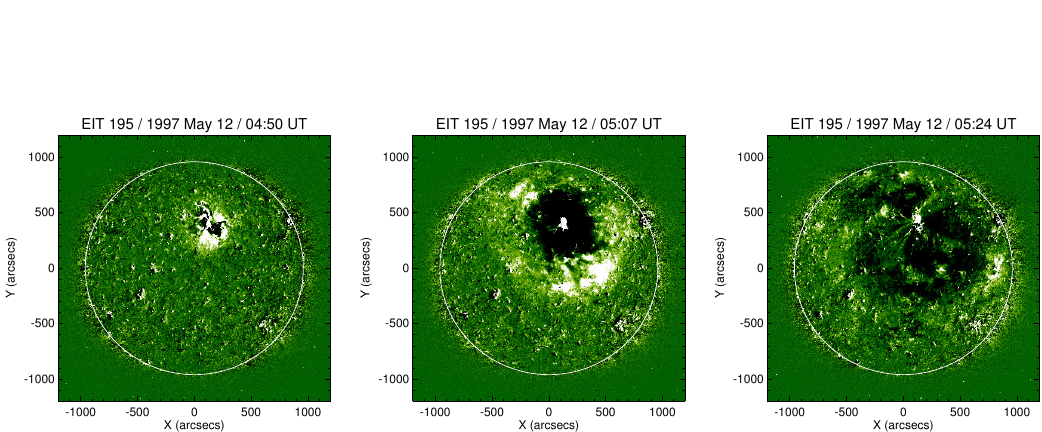
Figure 3: One of the first large-scale coronal waves observed: the iconic EIT wave of 1997 May 12, studied by Thompson et al. (1998). Running difference images observed at 195 ˚A are shown. A diffuse bright front is propagating quasi-isotropically through the corona.